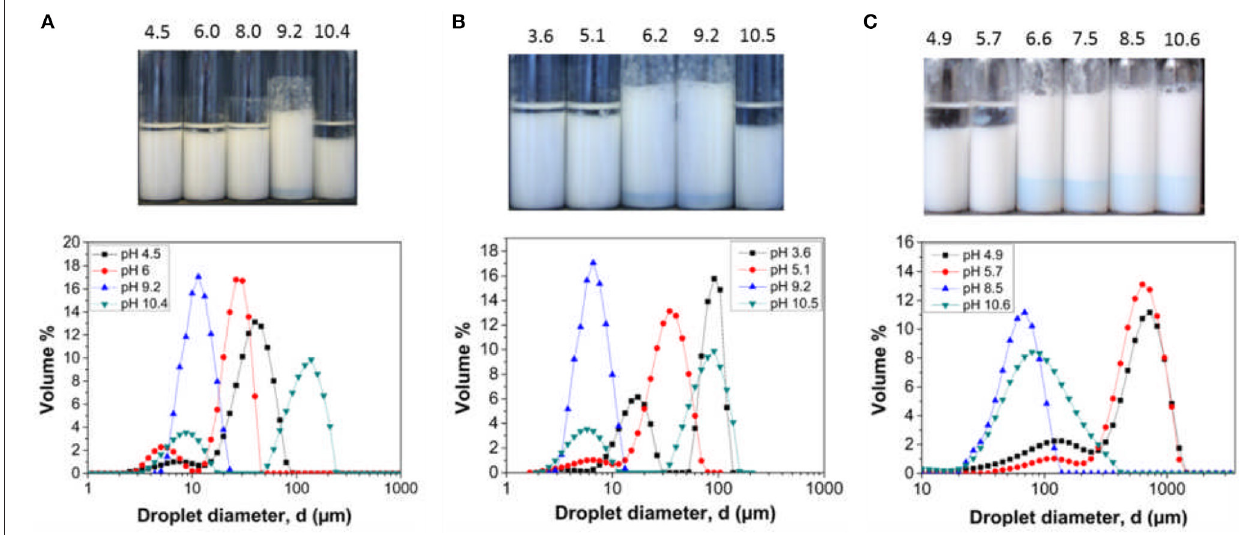
FIGURE 5 | Digital images (top) and droplet size data (bottom) for hexadecane in water emulsions stabilized by (A) LP-DMAEMA 54 , and (B) LP-DMAEMA 108 , and (C) LP-DMAEMA 245 as a function of pH in the presence of 0.01M KNO 3 . Measurements were performed at 25 ◦ C.